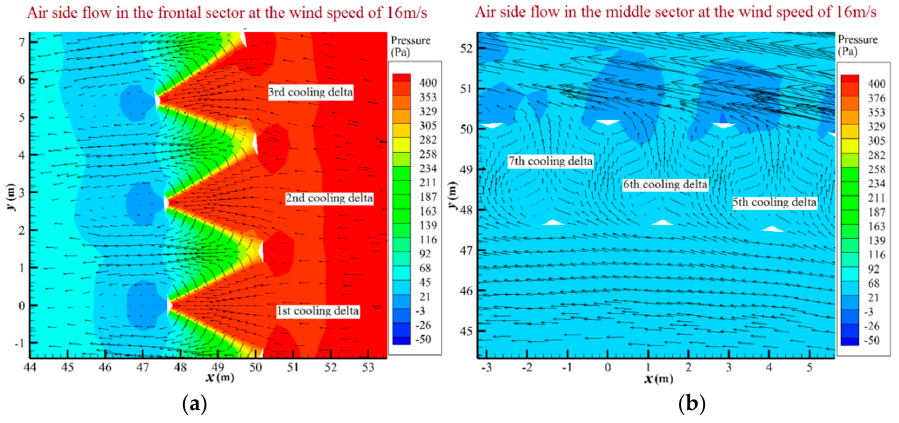
Figure 12. Air flows of representing deltas in frontal and lateral sectors under crosswind of 16 m/s, ( a ) frontal section; ( b ) middle section.